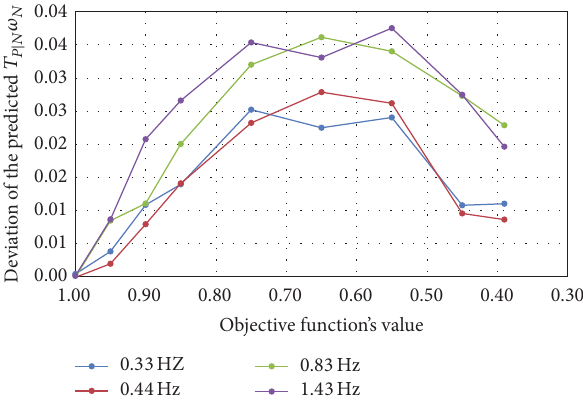
Figure 7: The deviation of predicted angles without calibration process for different gust